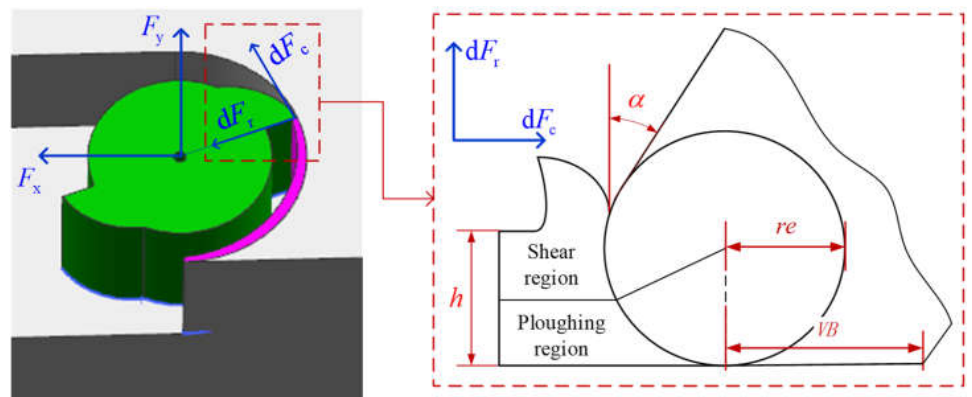
Figure 2. The nonlinear cutting force model in micro-milling.